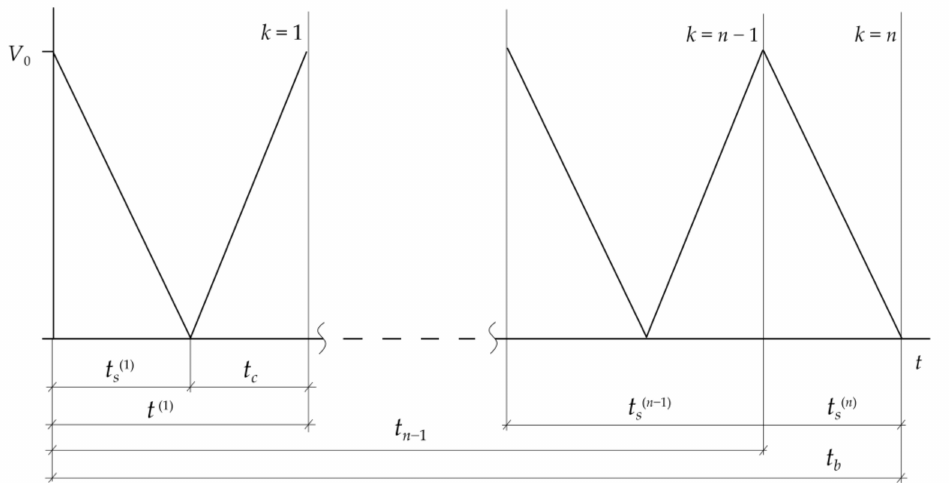
Figure 1. Scheme of sliding velocity variations during repetitive short-term (RST) braking mode. Thus, the duration of one full cycle was t k = t overall time of all full braking cycles was t n − 1 = performed with the applied brake, so speed V ( n ) dropped from initial value V 0 to zero ( n ) at stop moment t = t s . Thus, the total time of the RST operation mode of braking was ( n ) t b = t n − 1 + t s